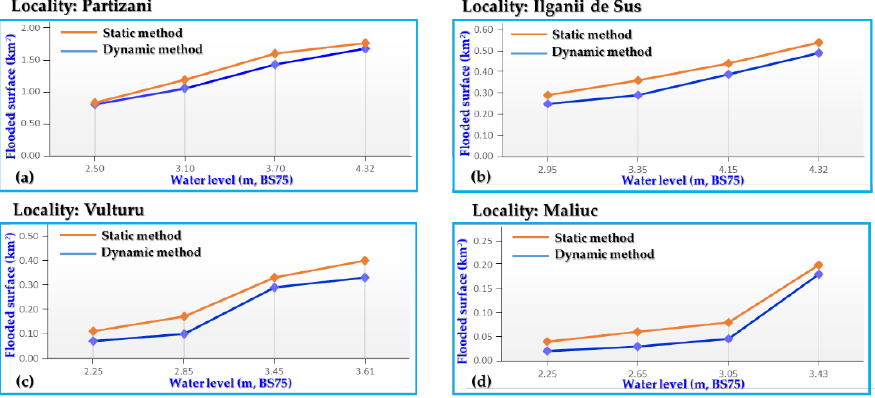
Figure 15. The differences of flooded area for the analyzed scenarios by using static method and dynamic method at: ( a )—Partizani, ( b )—Ilganii de Sus, ( c )—Vulturu, and ( d )—Maliuc settlements.